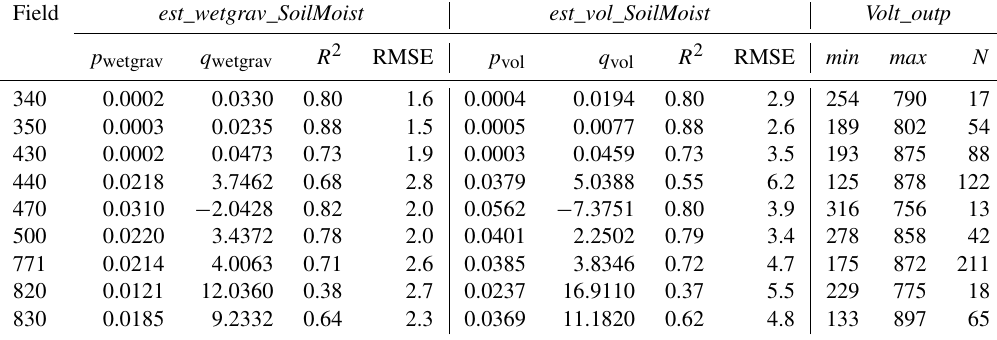
Table 5. Coefficients p x and q x of the linear calibration functions (Eq. 6) for the conversion of the output voltage ( Volt_outp , in mV) measured with the ML2x sensor into gravimetric soil moisture ( est_wetgrav_SoilMoist , in wt% relative to the wet mass) and volumetric soil moisture ( est_vol_SoilMoist , in %vol), corresponding coefficients of determination (Pearson’s R 2 ) and root mean square errors (RMSEs), and the range and number N of Volt_outp values involved in the calibration